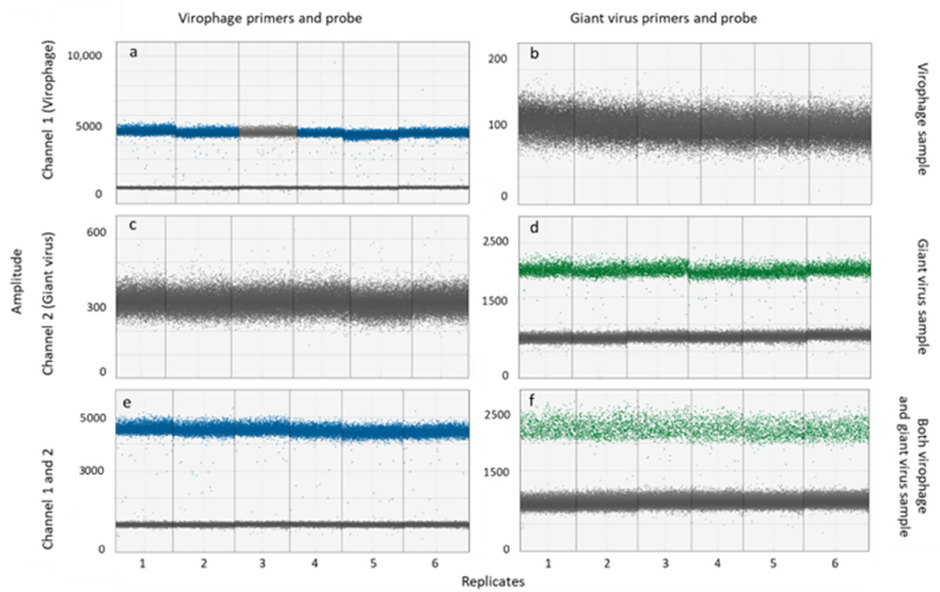
Figure 1. Summary of Quantasoft analyses for 1D-scatter plots of droplet fluorescence for both virophage and giant virus in singleplex and multiplex assays (technical replicates n = 6). ( a – d )